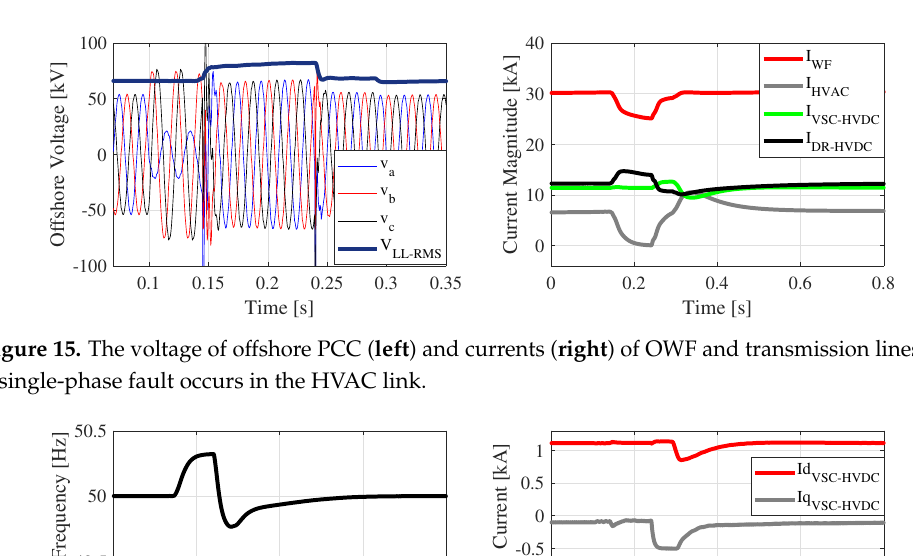
Figure 14. Active ( left ) and reactive ( right ) power of OWF and transmission lines when a single-phase fault occurs in the HVAC link.